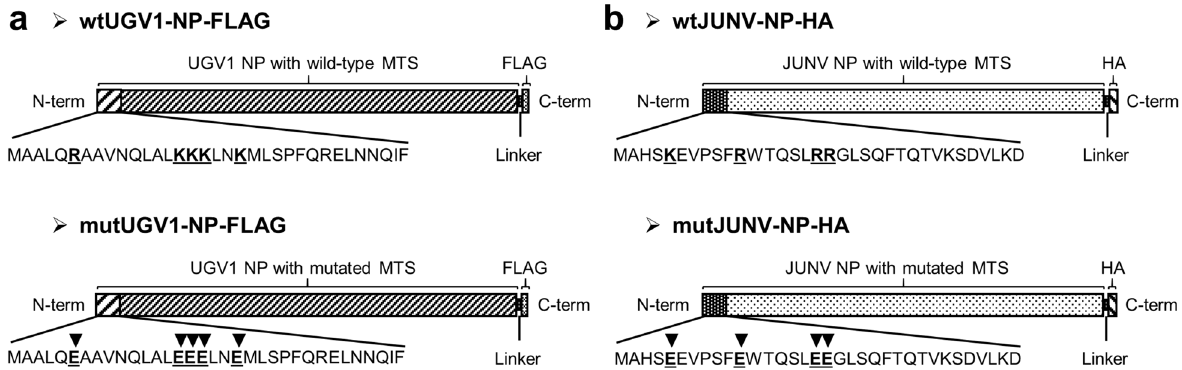
Figure 2. Arenaviral NPs transfection constructs. ( a , b ) Schematic representation of the wild-type (wt) and the mutated (mut) versions of the UGV-1 NP ( a ) and JUNV NP ( b ) expressed from a pCAGGS-FLAG or pCAGGS-HA construct, respectively, and used for transfections. Black arrowheads in the putative MTSs (first N-terminal 34 amino acids shown) indicate the positions of the amino acid substitutions of the mut versions compared to the corresponding wt sequences. Both wt and mut UGV-1 NPs are fused in frame with a C-terminal FLAG tag, separated by a linker sequence ( a ). Both wt and mut JUNV NPs are fused in frame with a C-terminal HA tag, separated by a linker sequence ( b